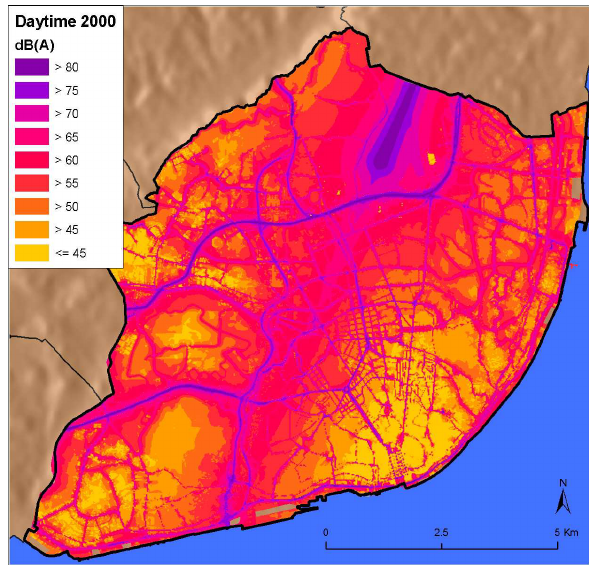
Figure 3. Global daytime noise levels for Lisbon in 2000 For 2009, only two noise layers were available, mapping noise levels using five classes: Nighttime noise (L n ), and daytime noise (L den ). L n represents the annual A-weighted long-term average sound pressure for the night period (23:00-7:00), while L den refers to the entire daily cycle, hence including measurements taken in day, evening, and night periods (Figure 5).